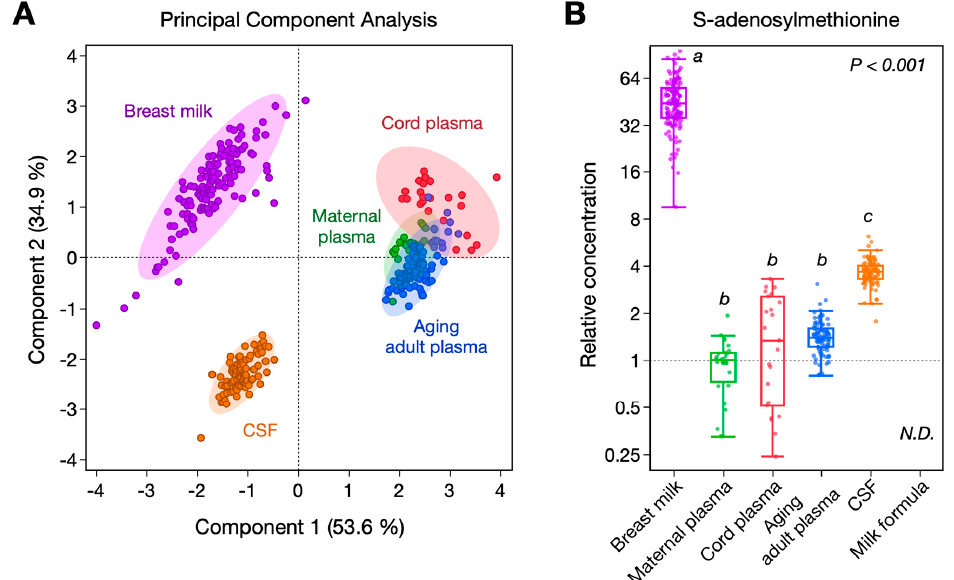
Figure 2. One − carbon metabolite profiling in biofluids and milk formula. One-carbon metabolite concentrations were measured in breast milk (purple, n = 142), cord blood plasma (red, n = 23), maternal plasma (green, n = 28), aging adult plasma (blue, n = 91), CSF (orange, n = 92), and milk formula ( n = 11). ( A ) PCA score plot based on metabolite concentrations in the different biofluids; shaded areas show 95% confidence regions. ( B ) Boxplot of SAM concentration in biofluids and milk formula relative to the median values for the maternal plasma samples shown with logarithmic Y-axis. Kruskal–Wallis test with post hoc Dunn method was applied; groups not connected by the same letter show statistical differences ( p < 0.05). CHO, choline; BET, betaine; MET, methionine, SAM, S-adenosylmethionine; SAH, S-adenosylhomocysteine; CYS, cystathionine; tHCY, total homocysteine; CSF, cerebrospinal fluid; N.D., not detected. Multivariate correlation coefficients between each metabolite in human breast milk and the corresponding probability values are shown in Table 2. As may be expected, many metabolites are significantly correlated in the one ‐ carbon metabolism pathway. Of interest is the absence of a significant correlation between SAM and its substrate precursor metabolite methionine and demethylated metabolite tHCY. Table 2. One ‐ carbon metabolite correlations in breast milk samples. CHO